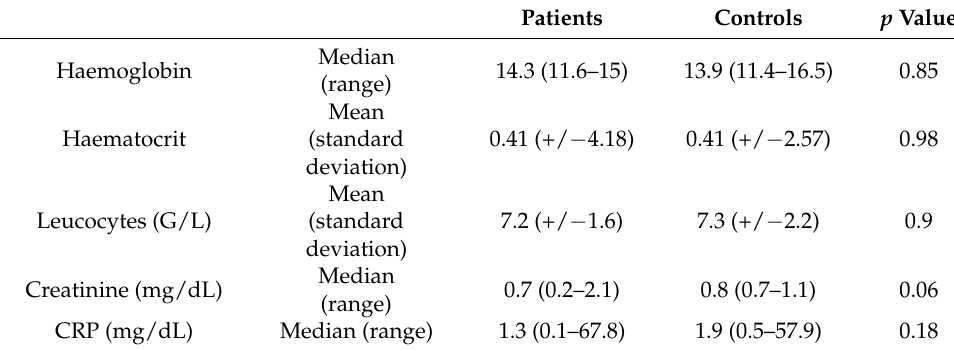
Table 2. Laboratory results